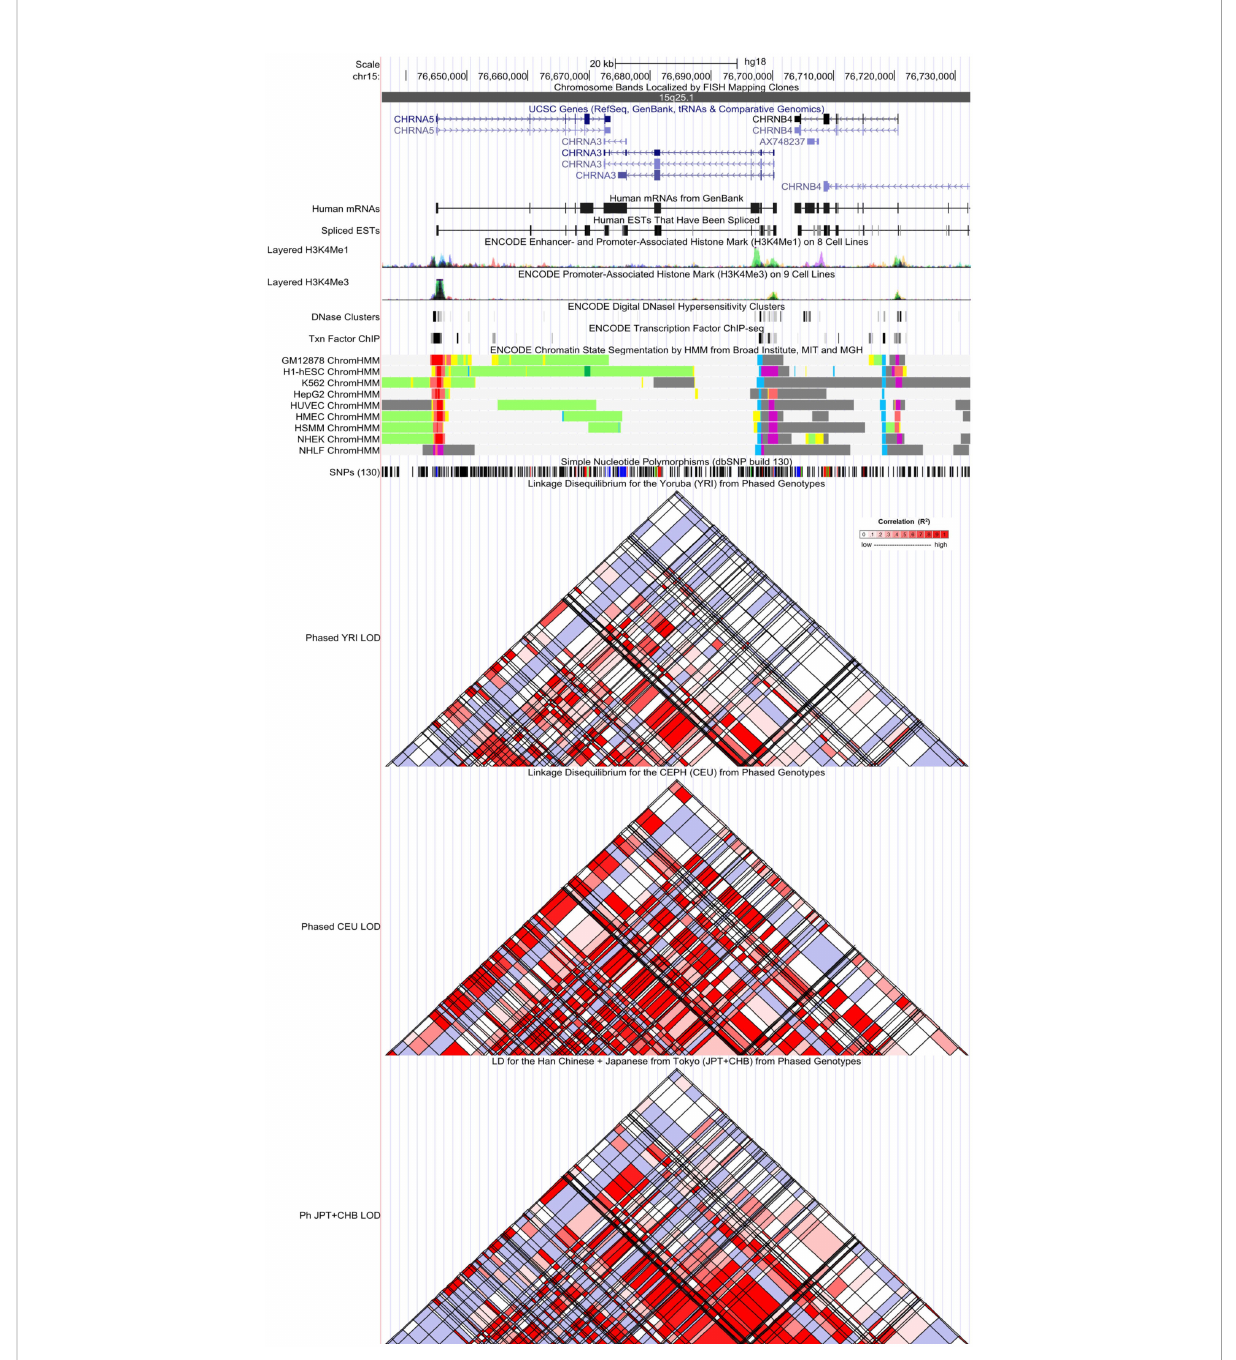
FIGURE 2 Evidence from the Encyclopedia of DNA Elements (ENCODE) data for the regulatory function of variants in 15q25.1 using the UCSC Genome Browser. The plot represents 15q25.1 within a 20-kb window centered on the CHRNA5 – CHRNA3 gene region. Tracks (from top to bottom) in each of the plots are Genome Base Position, Chromosome Bands, UCSC Genes, Human messenger RNAs from GenBank, Human expressed sequence tag (ESTs) That Have Been Spliced, ENCODE Enhancer and Promoter-Associated Histone Mark (H3K4Me1) on 8 Cell Lines, ENCODE Promoter-Associated Histone Mark (H3K4Me3) on 9 Cell Lines, ENCODE Digital DNaseI Hypersensitivity Clusters, ENCODE Transcription Factor ChIP-seq, ENCODE Chromatin State Segmentation by Hidden Markov Model (HMM) from Broad Institute (bright red, active promoter; light red, weak promoter; purple, inactive/poised promoter; orange, strong enhancer; yellow, weak/poised enhancer; blue, insulator; dark green, transcriptional transition/elongation; light green, weak transcribed; gray, polycomb-repressed; light gray, heterochromatin/low signal/repetitive/copy number variation), Simple Nucleotide Polymorphisms (dbSNP build 130), Linkage Disequilibrium for the Yoruba (YRI) from Phased Genotypes, Linkage Disequilibrium for the CEPH (CEU) from Phased Genotypes, and LD for the Han Chinese + Japanese from Tokyo (JPT+CHB) from Phased